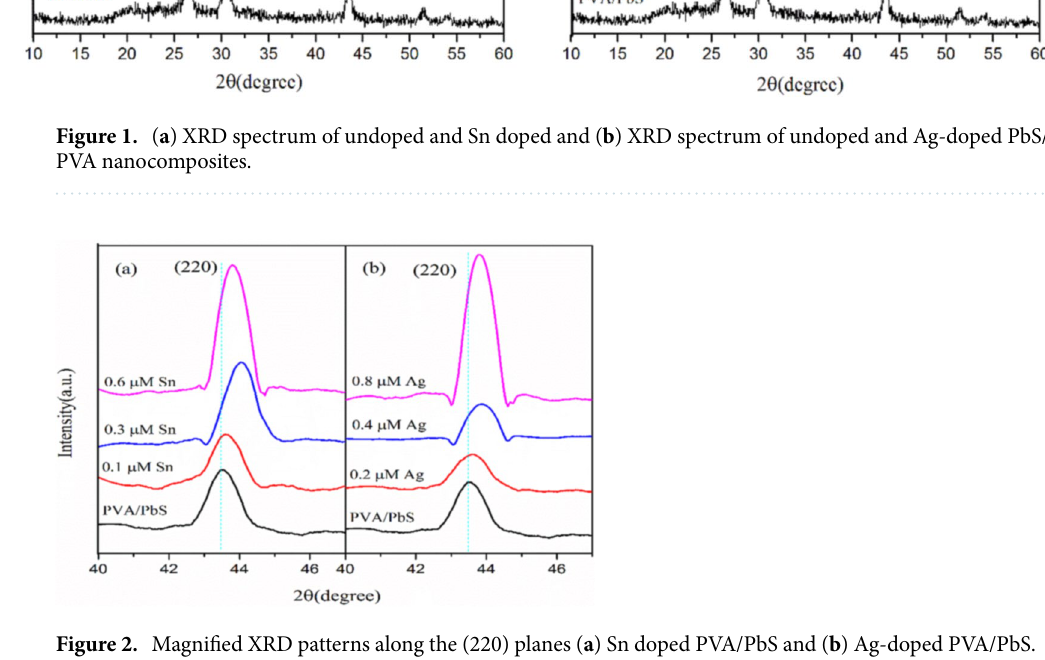
Figure 2. Magnified XRD patterns along the (220) planes ( a ) Sn doped PVA/PbS and ( b ) Ag-doped